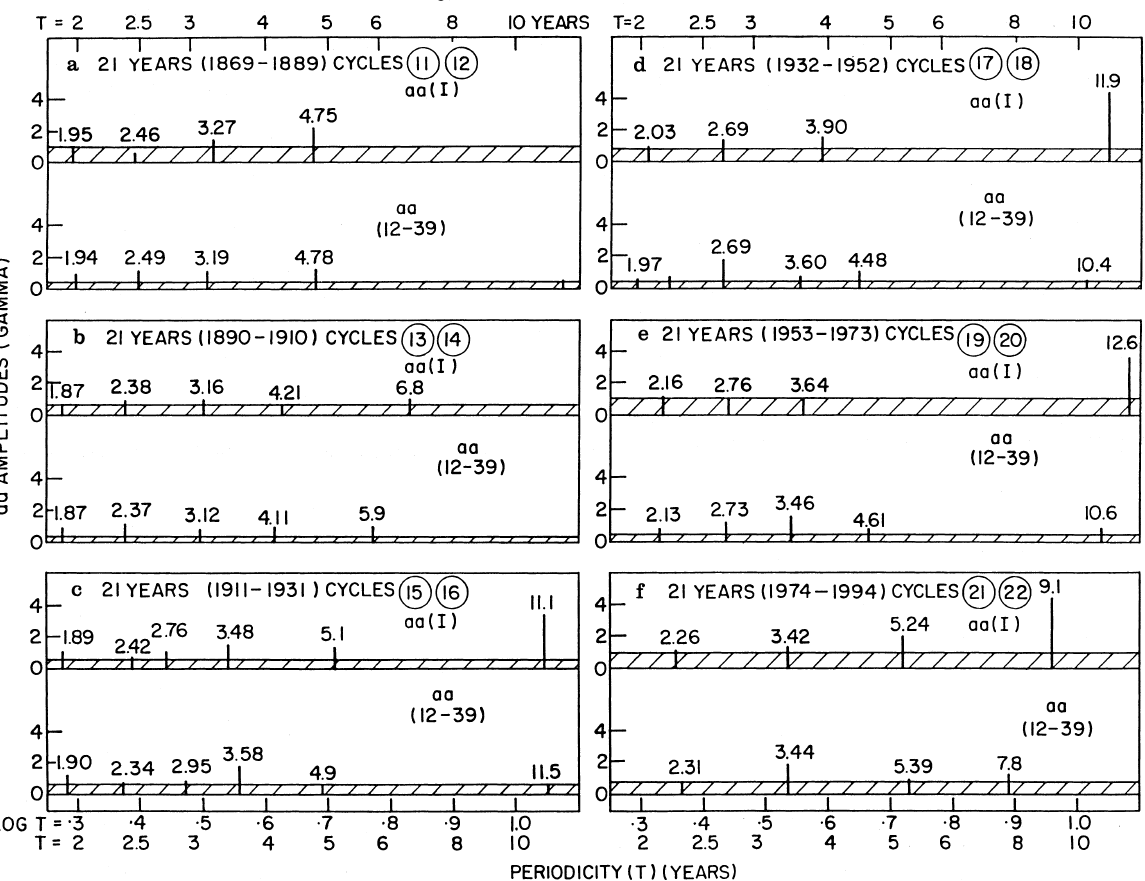
Fig. 5a–f. Spectra for aa(I) and aa (12–39) for consecutive 21 year